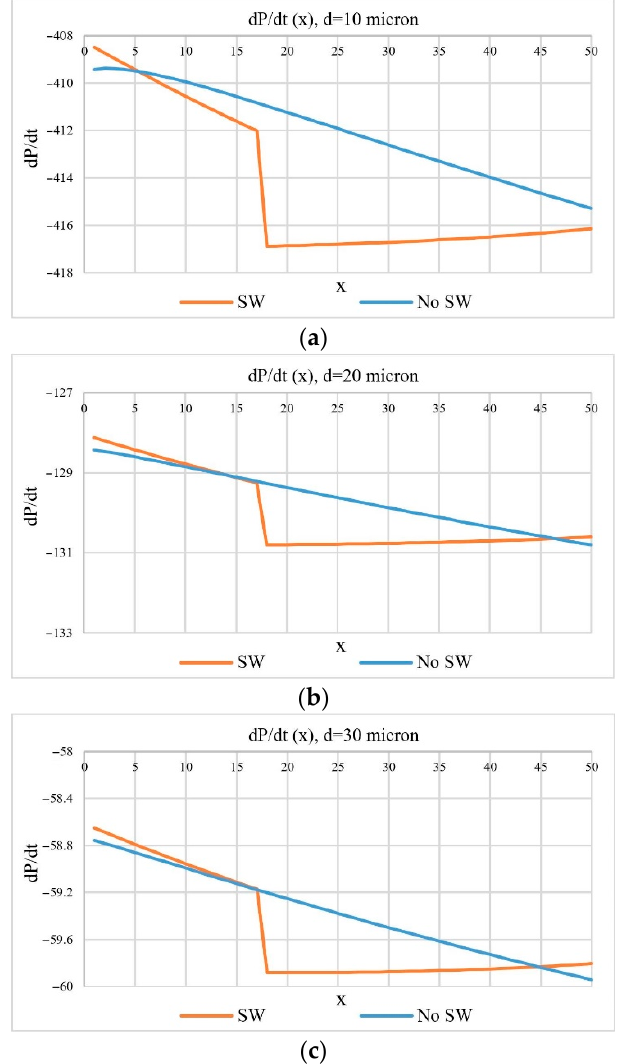
Figure 5. The droplet breakup rate by the longitudinal coordinate. Blue line shows parameters without shock wave; red line—parameters with the shock wave. ( a ) d = 10 micron, ( b ) d = 20 micron, ( c ) d = 30 micron.